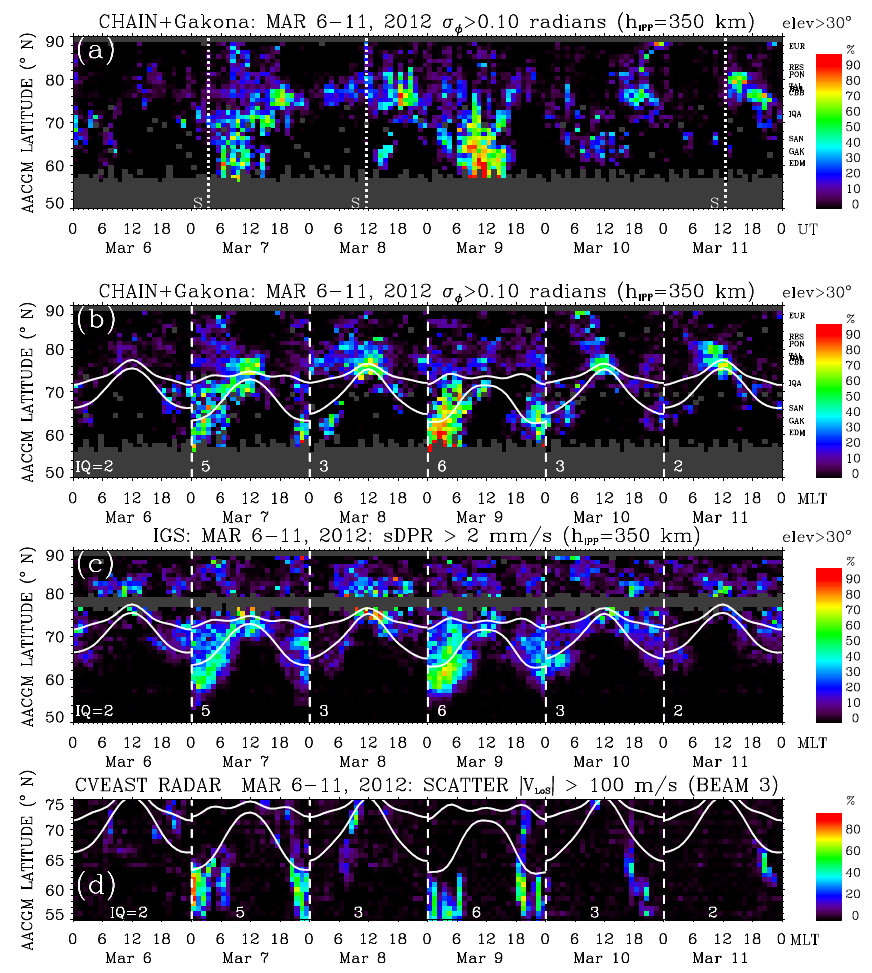
Figure 3. The occurrence of phase scintillation (a, b) σ (cid:56) >0.1rad, (c) sDPR>2mms − 1 ), and (d) Christmas Valley East radar backscatter ( V LOS >100ms − 1 ) from 6 to 11 March. The maps are shown as a function of AACGM latitude and (a) UT or (b–d) MLT. The dotted vertical lines in the top panel indicate interplanetary shock arrival times in UT. The dashed vertical lines separate days mapped in MLT. The IQ value of the statistical auroral oval is chosen approximately proportional to a maximum 3-hourly Kp